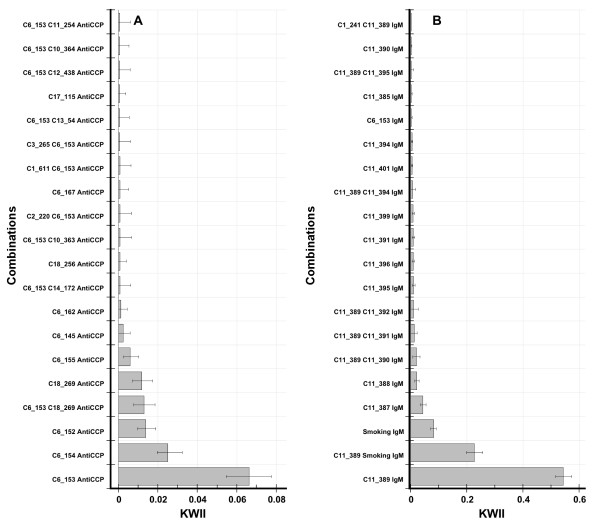
The KWII spectra for one-variable and two- variable containing combinations for the "10K GAW15 data set" with Anti-CCP antibody status (Figure 5A) and IgM status (Figure 5B) as the quantitative traits of interest are shown. The variable combinations are indicated on the y-axis; the chromosome number and the SNP identifiers are provided for SNPs. The bars represent mean values and the upper and lower error bars are the 95th and 5th percentiles of KWII values, respectively.